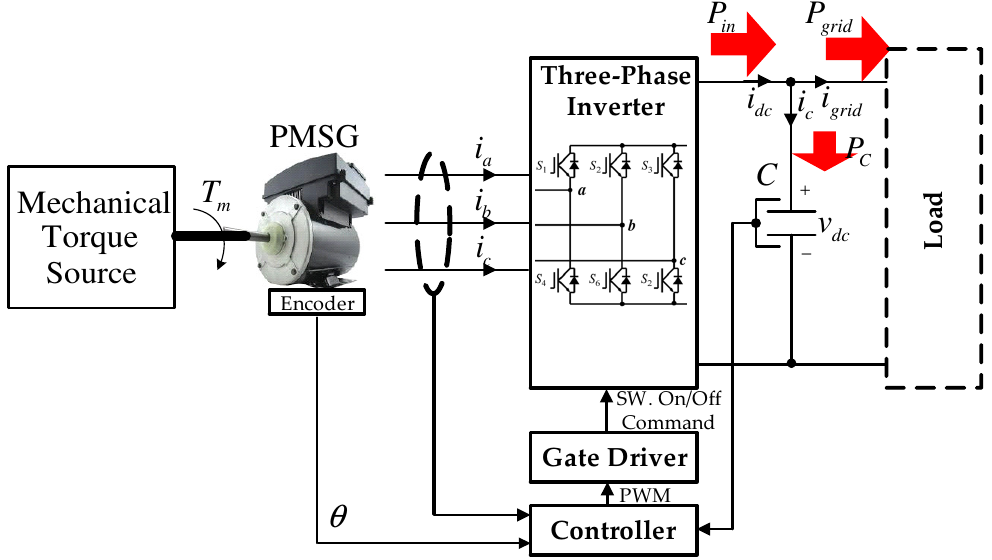
Figure 1. PMSG power system